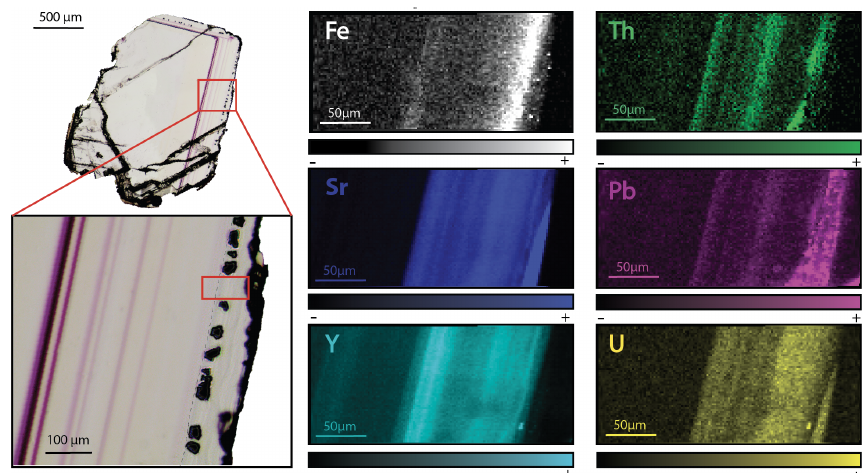
Figure 6. SR-XRF imaging of the transition between Fl og 1 and Fl og 2 in PP18S15 showing the distribution of Fe, Th, Sr, Pb, Y and U contents. Map dimensions are 261µm × 122µm.